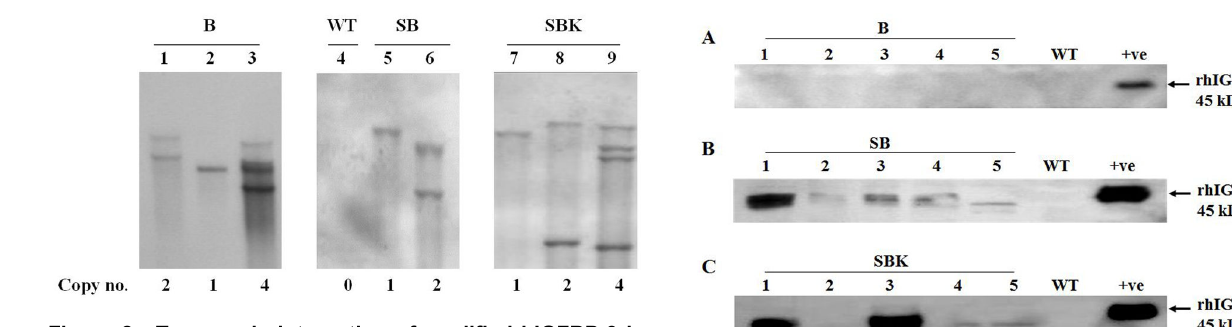
Anti-proliferation of MCF-7 breast cancer cells and HT-29 colon cancer cells Inhibitory effect of commercial rhIGFBP-3. Different